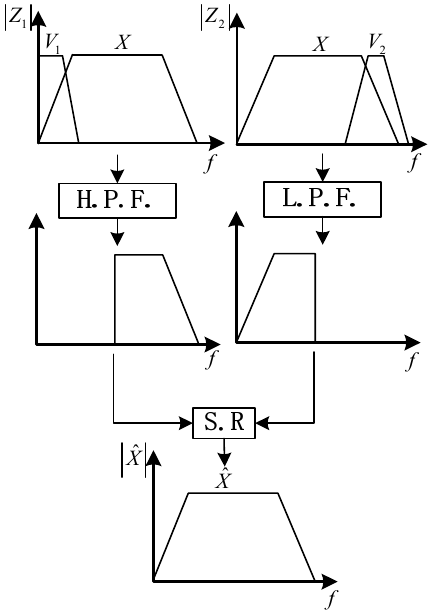
Figure 1. Principle of complementary filter.